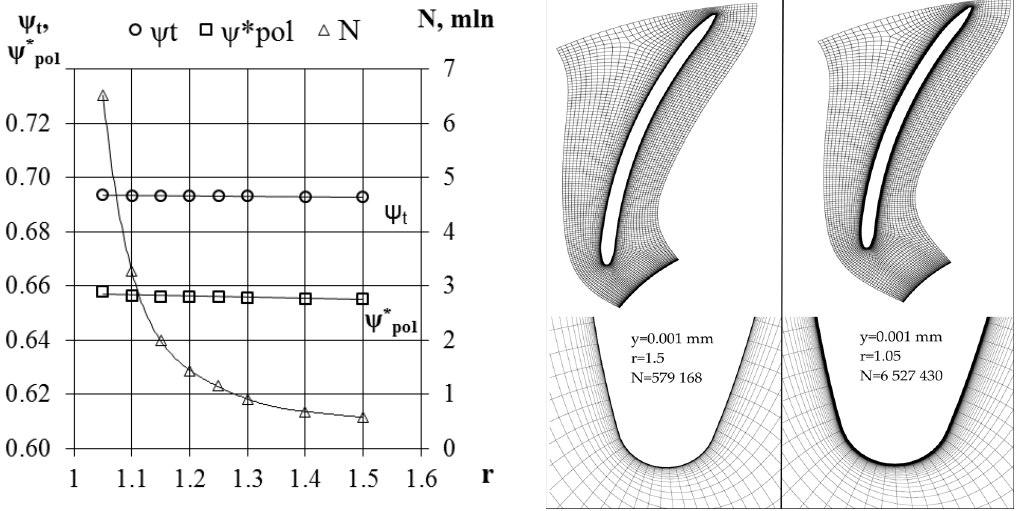
Figure 2. Impeller mesh independent